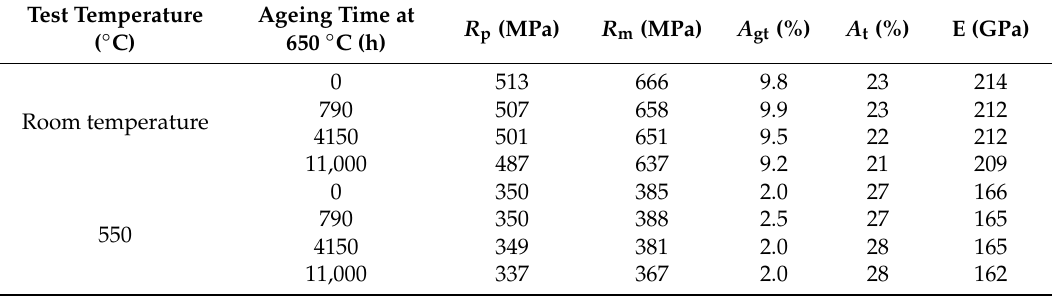
Figure 5. Stress–strain curves of the as-received and aged steel P91 at room and elevated temperatures. Table 2. Mechanical properties of the P91 steel plate.